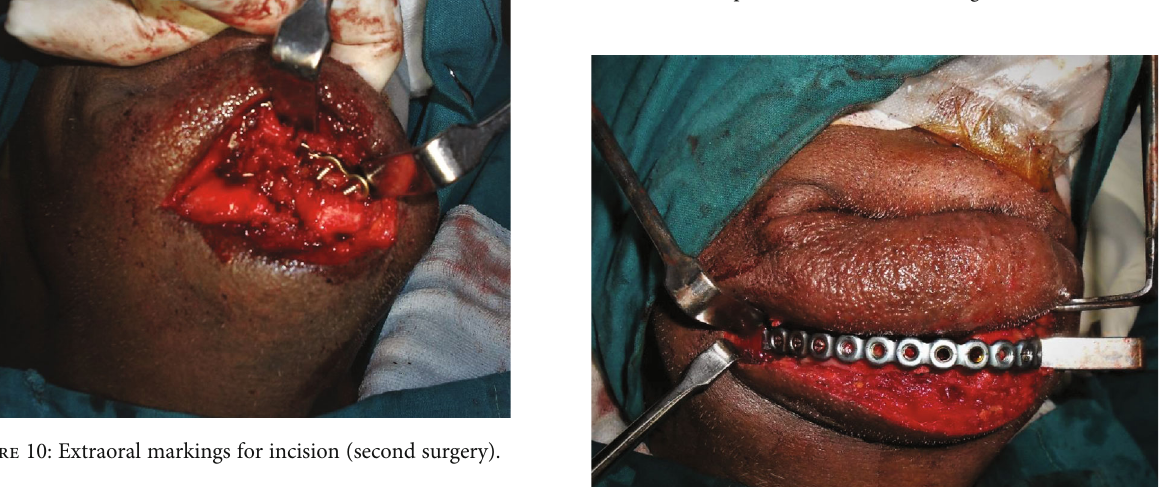
Figure 11: Exposure of the site, revealing a loose hardware.